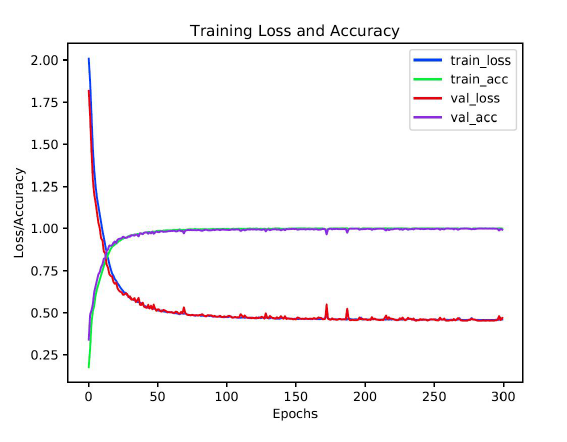
Figure 5. Loss and accuracy graph.